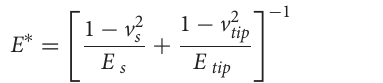
surface, the cantilever is pulled down by attraction forces